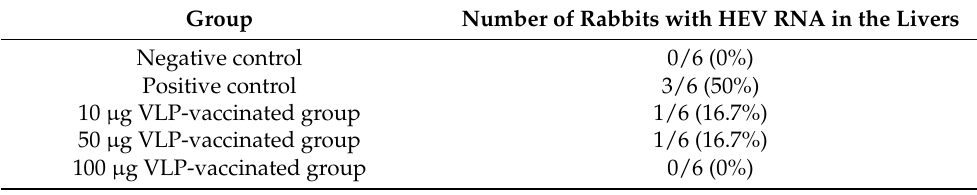
Table 3. Number of rabbits with HEV RNA in livers.